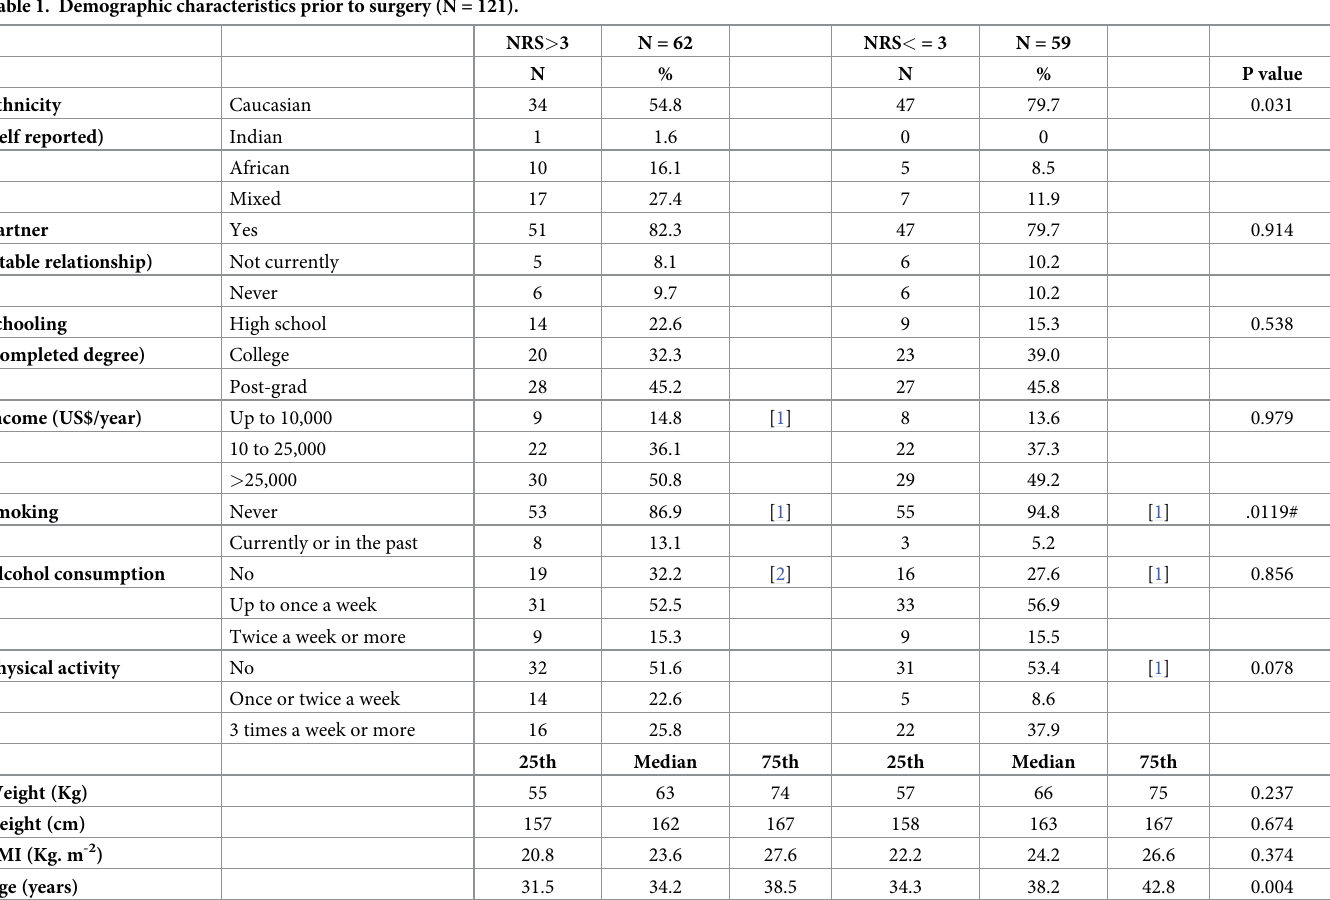
Table 1. Demographic characteristics prior to surgery (N =